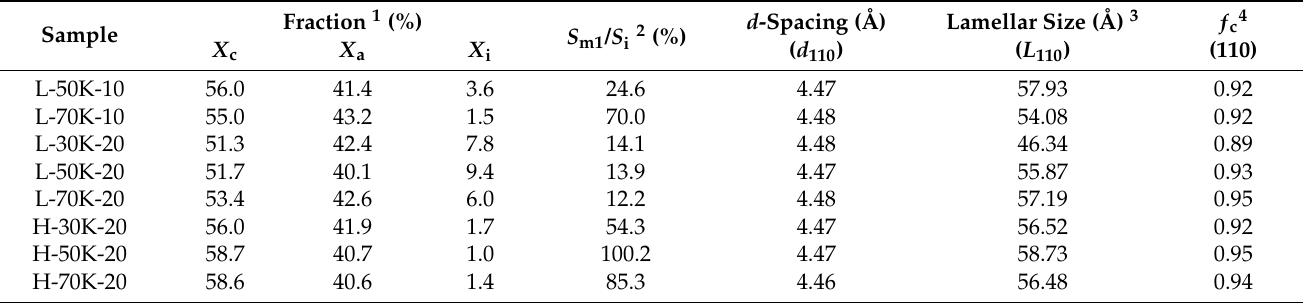
Table 2. Characterization data calculated from the 2D-WAXD patterns of the TLCP as-spun fibers obtained at various spinning conditions.